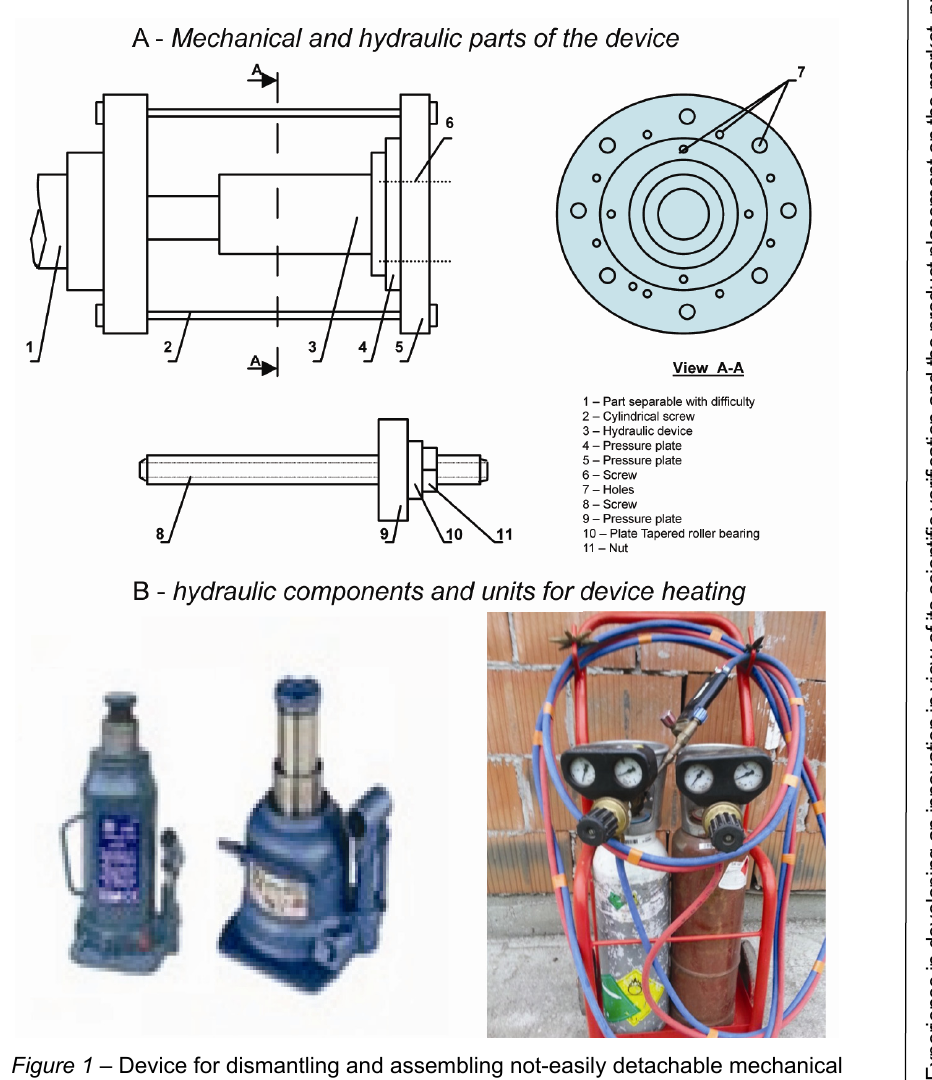
Figure 1 – Device for dismantling and assembling not-easily detachable mechanical and electrical